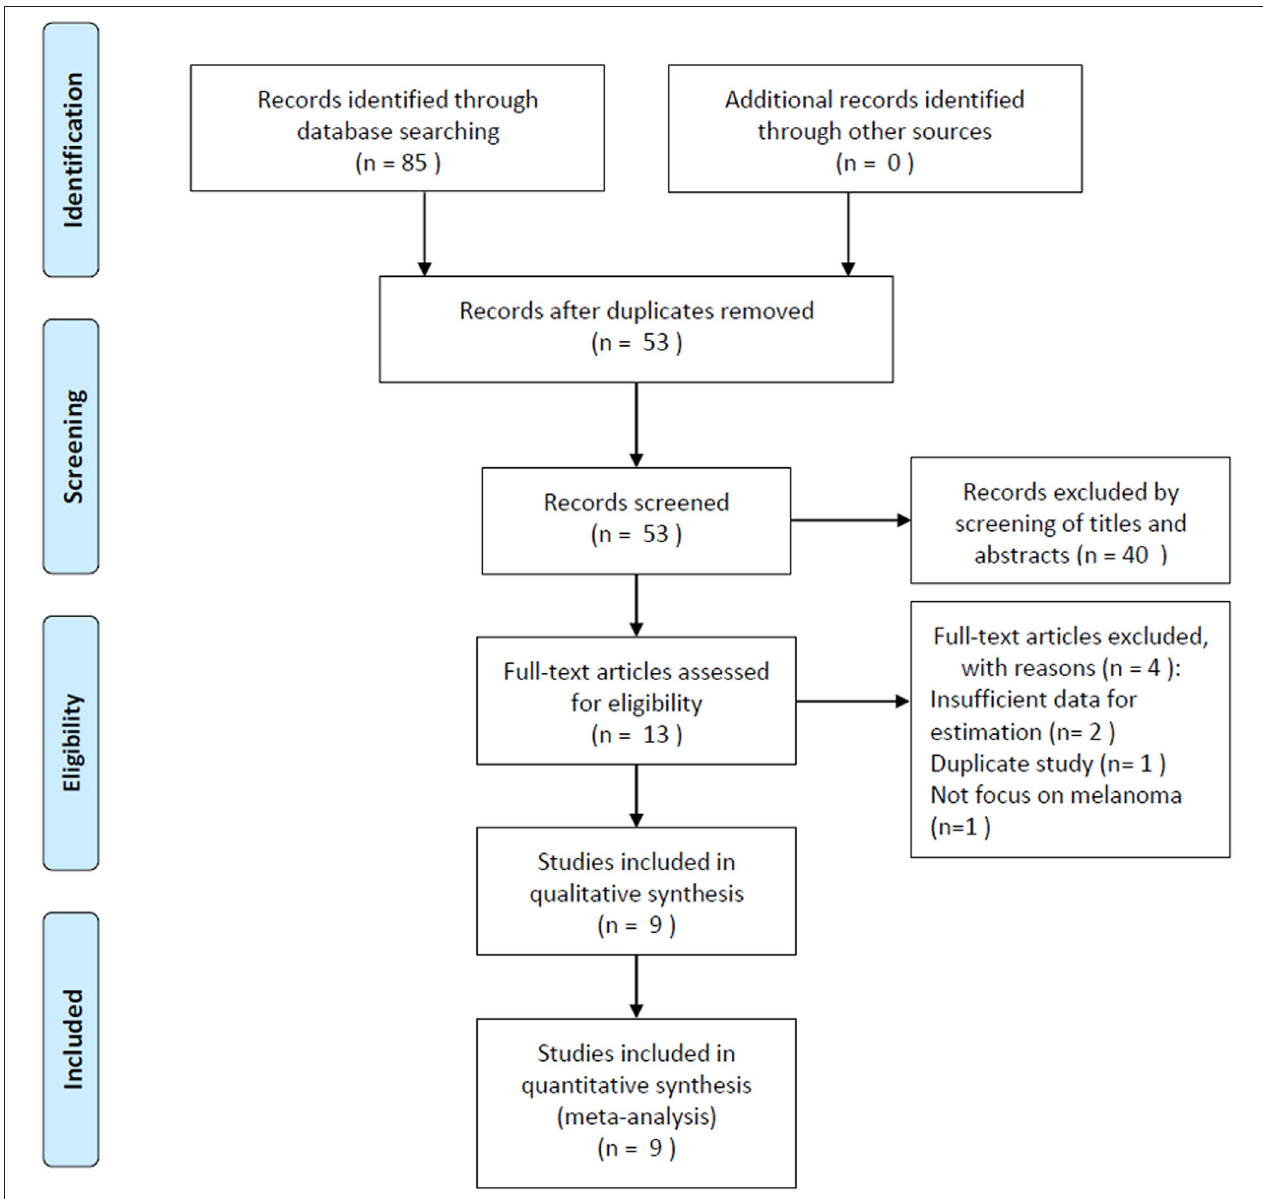
FIGURE 1 | The flowchart of study selection procedure in the